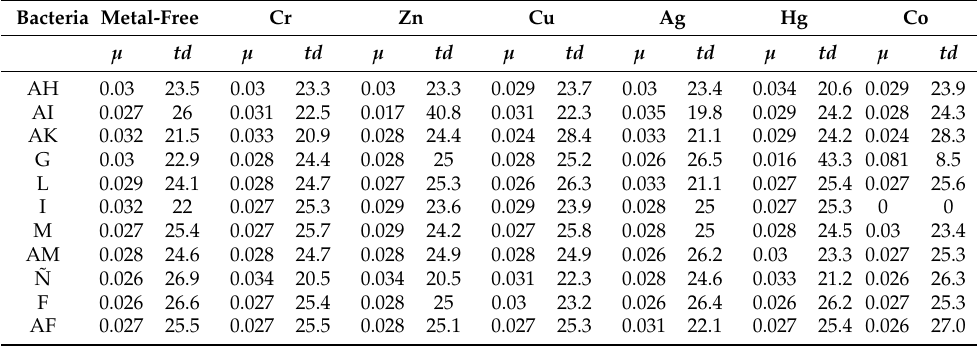
Figure 3. Growth curve proposed for the bacterial behaviour to heavy metals tested. (a) Metal-free, (b) Stimulating growth, (c) Un-inhibited growth and (d) Inhibited growth. (symbol = experimental data, line = fitting data). Table 4. Kinetic parameters determined for the bacteria and heavy metals